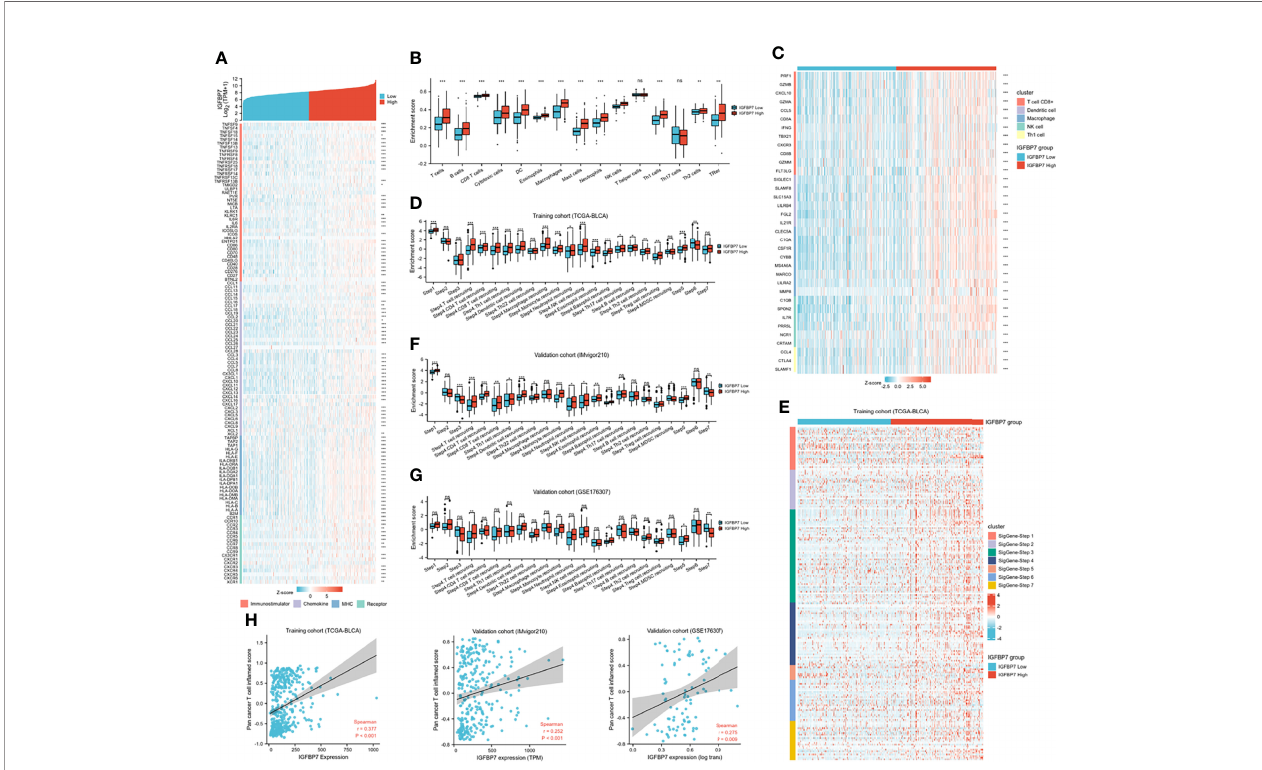
FIGURE 3 | The effect of IGBP7 on Immunological Characteristics in BLCA. (A) Differences in the expression of 122 immunomodulators (immunostimulators, chemokines, MHC and receptors) between high- and low-IGFBP7 groups in BLCA. (B) Enrichment scores of 15 immune cell in fi ltrates in high- and low-IGFBP7 groups. (C) Expression levels of the gene markers of the fi ve common TIICs in the high- and low-IGFBP7 groups. (D, F, G) The activities of the various steps of the cancer immunity cycle calculated by ssGSEA algorithm in the high- and low-IGFBP7 groups in three cohorts. (E) Differences in the various steps of the cancer immunity cycle between high- and low-IGFBP7 groups. (H) Correlations between IGFBP7 and the pan-cancer T cell in fl amed score in the TCGA, IMvigor210 and GSE176307 cohorts. *p< 0.05; **p<0.01; ***p<0.001. ns, no signi fi cance; ns, p ≥